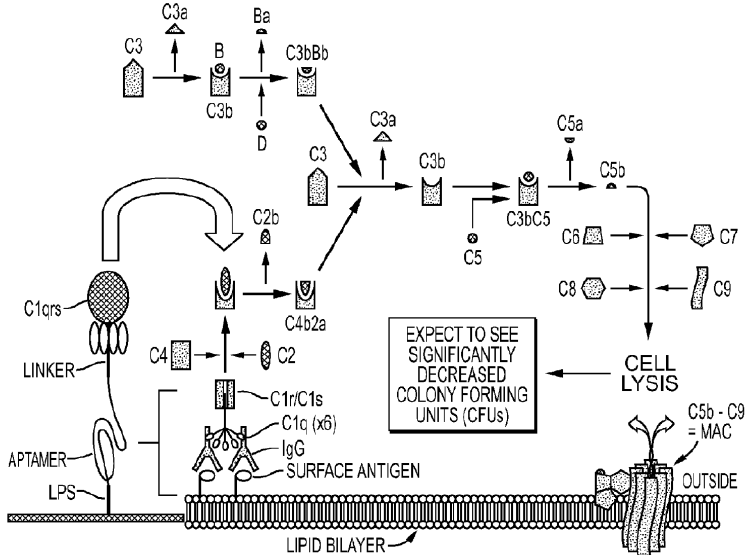
Figure 2. Schematic of the putative DNA aptamer-C1qrs conjugate-mediated triggering of the classical complement system to kill Gram negative bacteria and other thin-walled (cancer and some parasite) target cells by complement-mediated